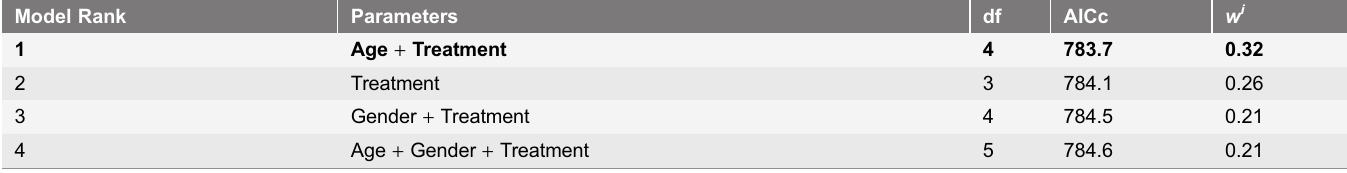
The table shows the top models (models within 2AICc units of the best model), with AICc values and Akaike weights ( w i ). The best model is